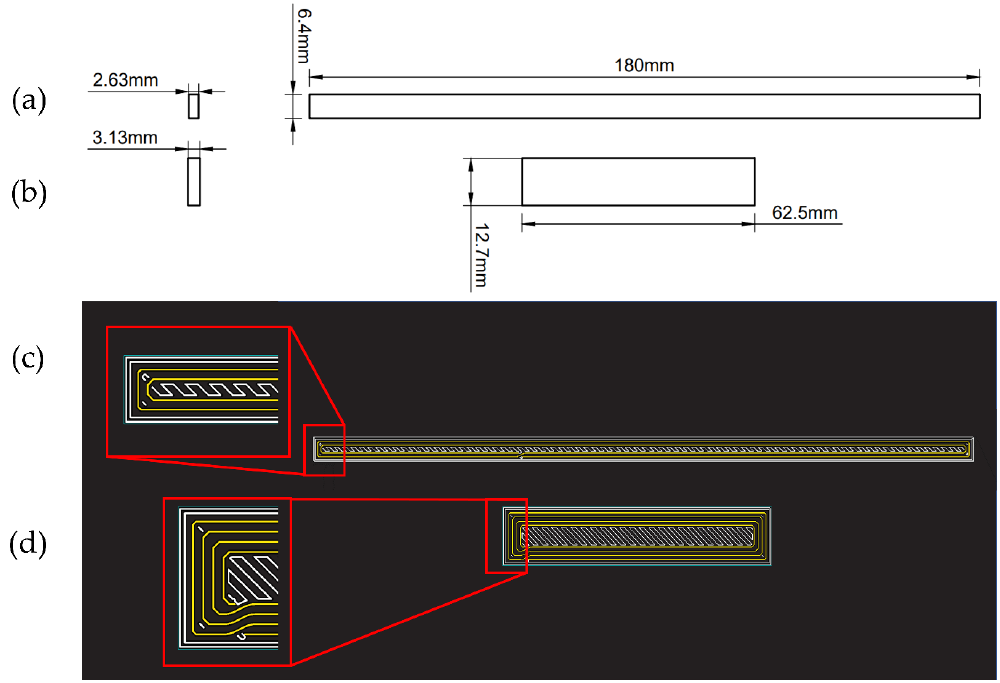
Figure 2. ( a ) Technical drawing of tension samples. ( b ) Technical drawing of bending samples. ( c ) Scheme of Kevlar ® reinforcement rings of tensile samples. ( d ) Scheme of Kevlar ® reinforcement rings of bending samples.